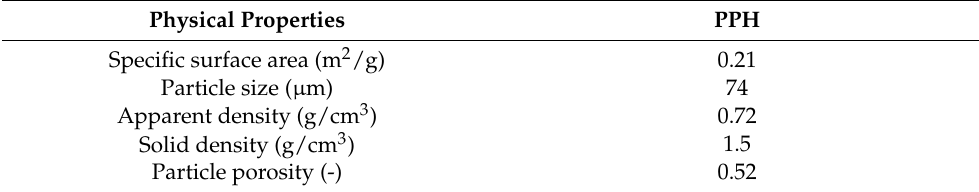
Table 1. Physical properties of PPH adsorbent